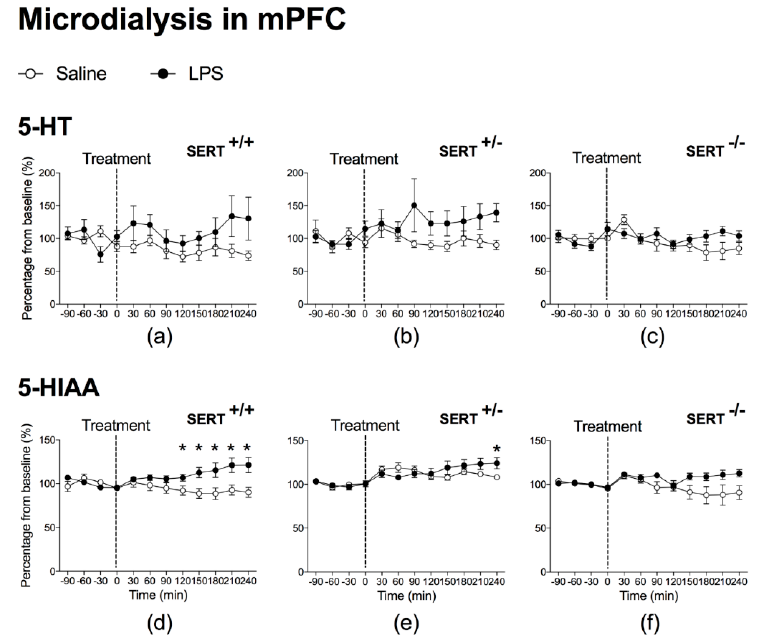
Figure 2. Microdialysis in the medial Prefrontal Cortex (mPFC). At t = 0 min, rats received Saline or LPS. Graph represents percentage from baseline (%) of 5-HT and 5-HIAA from each time point (min). Animals ( n ) per group were as follows: n = 7 for Saline-SERT +/+ rats ( a , d ) and n = 7 for LPS-SERT +/+ rats ( a , d ); n = 7 for Saline-SERT +/ − rats ( b , e ) and n = 8 for LPS-SERT +/ − rats ( b , e ); n = 8 for Saline-SERT − / − rats ( c , f ) and n = 7 for LPS-SERT − / − rats ( c , f ). Significance: * p <